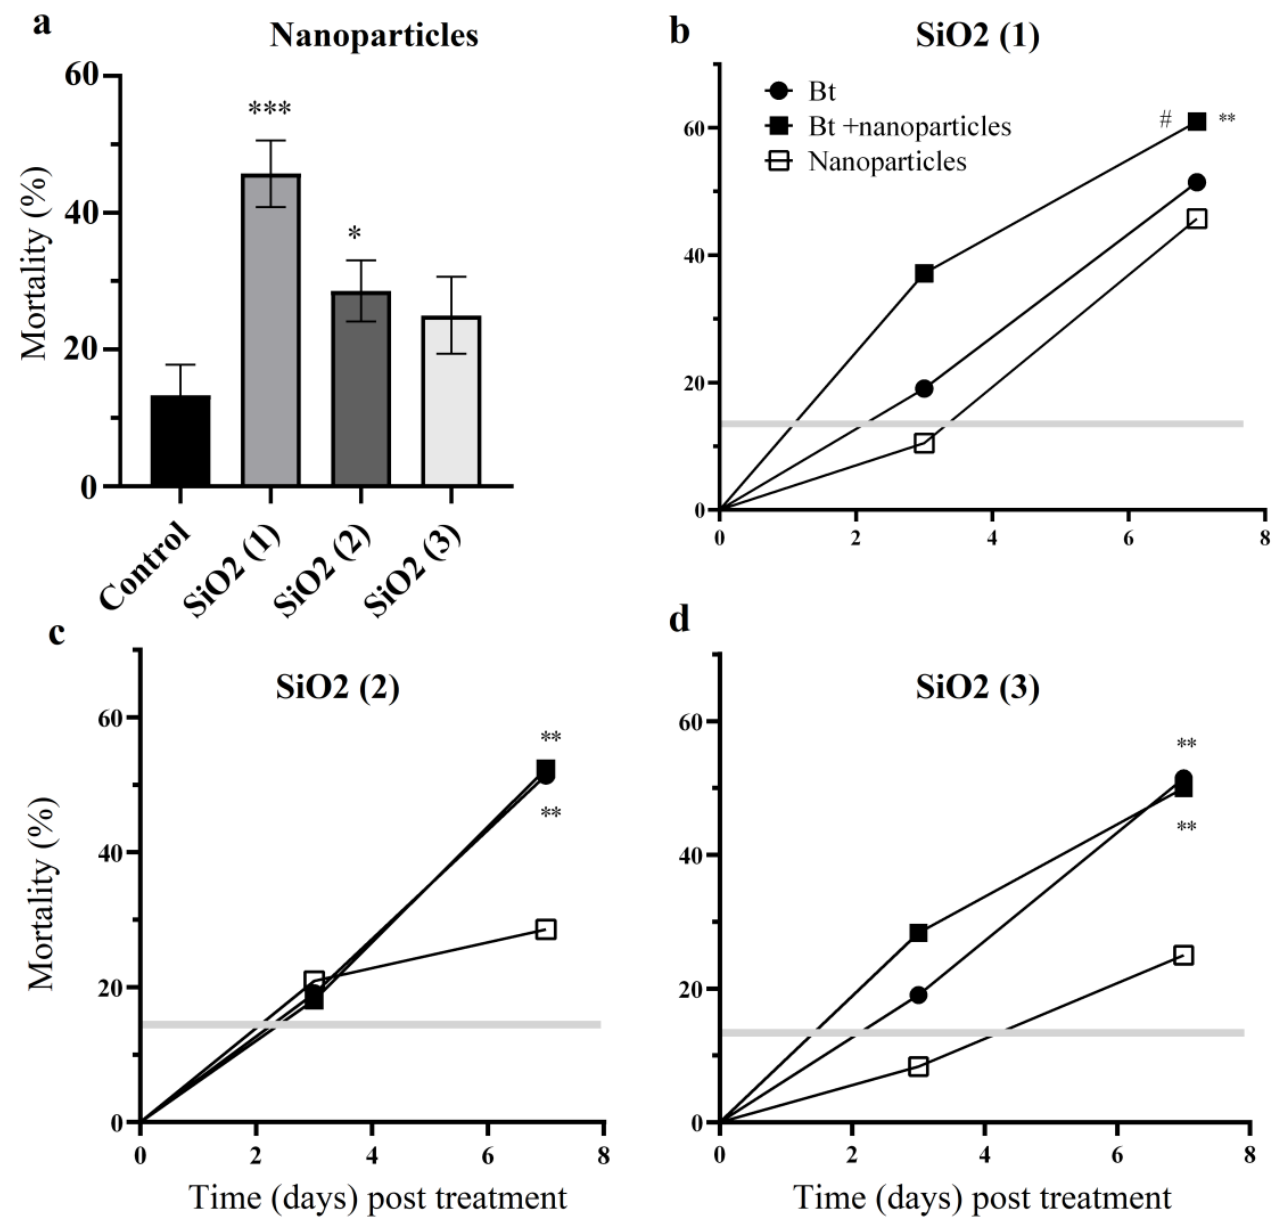
Figure 1. Survival of Leptinotarsa decemlineata larvae over seven days following treatment with silicon dioxide nanoparticles with epoxy SiO 2 (1), silane SiO 2 (2), amino SiO 2 (3) groups ( a ), bacteria Bacillus thuringiensis (Bt) and combination (Bt+ nanoparticles) ( b – d ). The gray bar represents the mortality (mean) in control (* p < 0.05; ** p < 0.01, *** p < 0.001 compared with native larvae (Control) ( a ); (** p < 0.01 compared with treatment by nanoparticles, # p < 0.05 compared with treatment by Bt) ( b – d ).